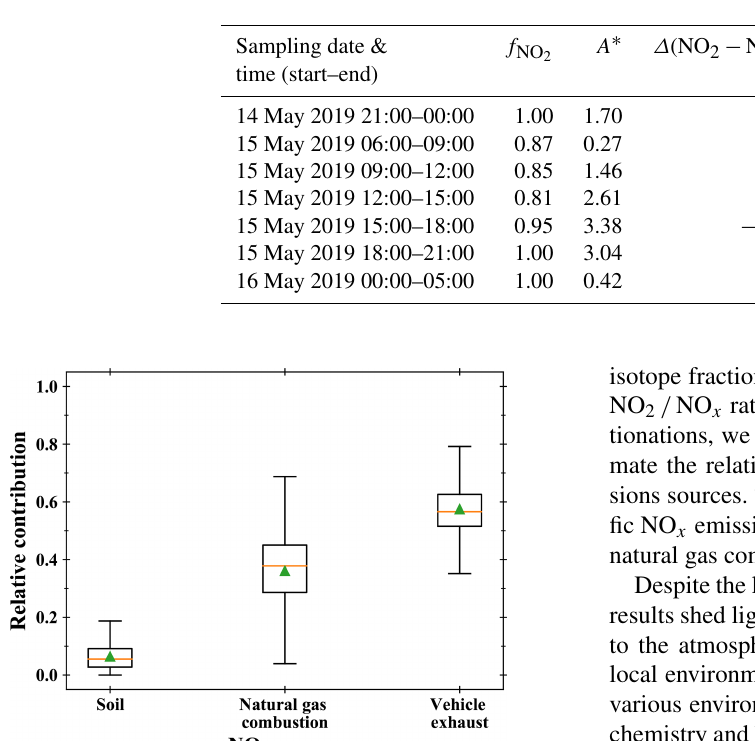
Table 3. Summary of measured f NO , calculated A ∗ values using Eq. (9) for daytime and Eq. (11) for nighttime, calculated isotopic frac- 2 tionation between NO 2 and NO x ( ∆ (NO 2 − NO x )) using Eq. (8) for daytime and Eq. (10) for nighttime, and δ 15 N(NO x ) estimated with ∆ (NO 2 − NO x ) and measured δ 15 N(NO 2 ).